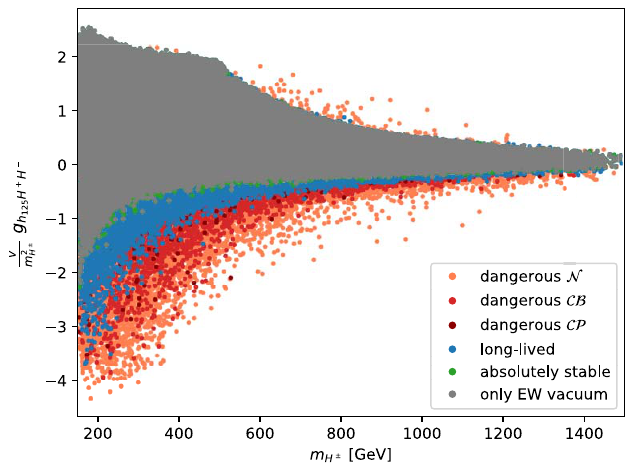
Figure 4 . The normalised coupling g code as in figure 3.